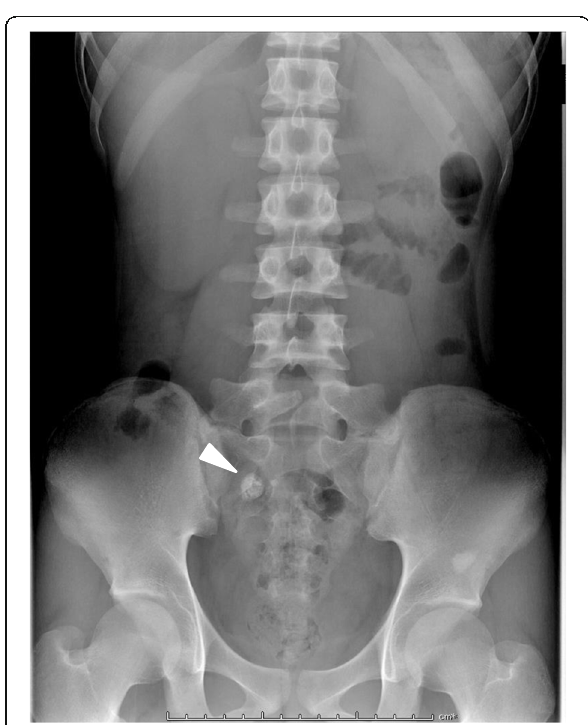
Fig. 1 Preoperative abdominal radiography. A solitary stone with peripheral calcification and a lucent center was identified on abdominal radiography